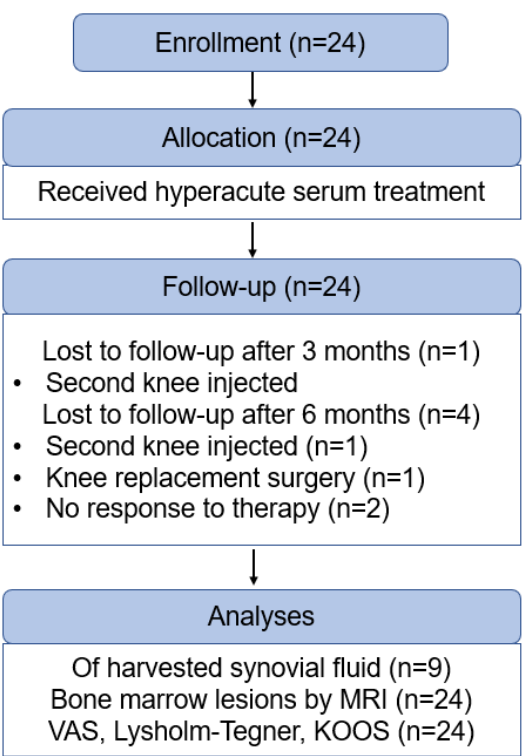
Figure 2. Flow diagram of participant enrolment, allocation, follow-up and analysis of the study trial.